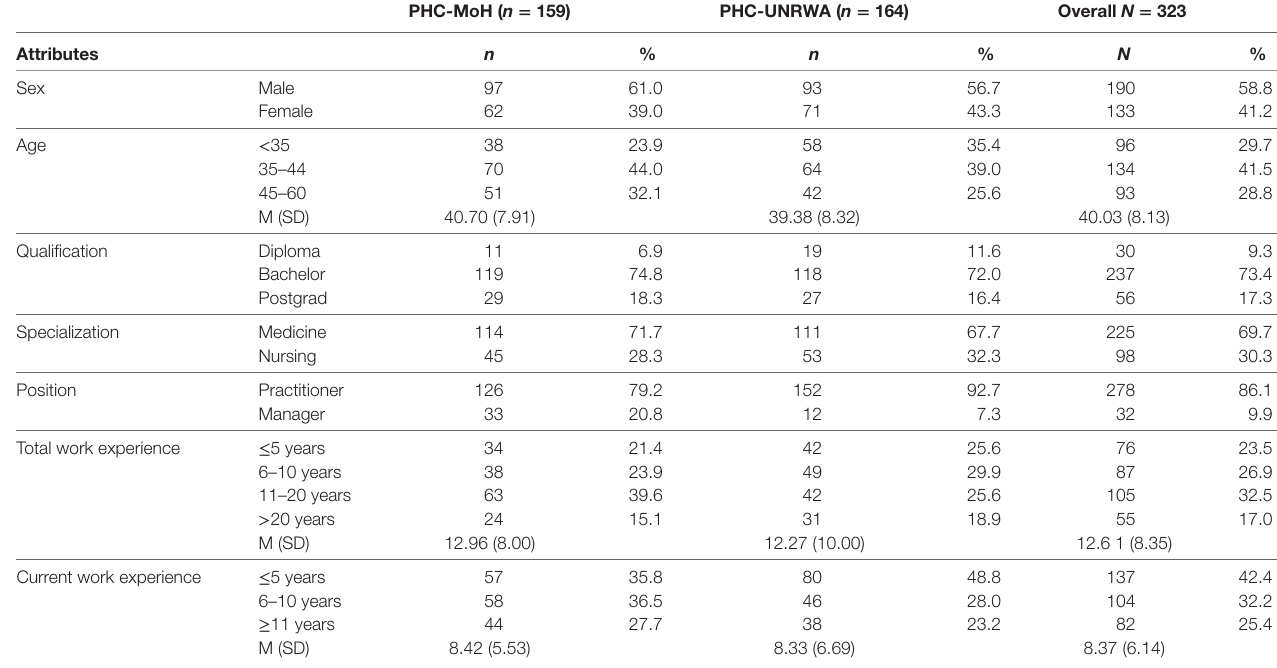
TaBle 2 | Respondent characteristics ( n =